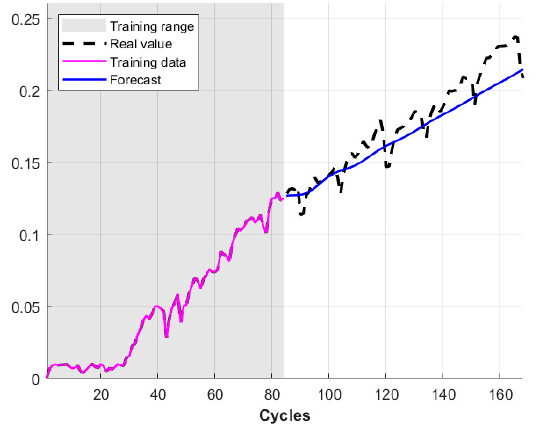
Figure 3. Forecasting algorithm based on historical data—the training data.